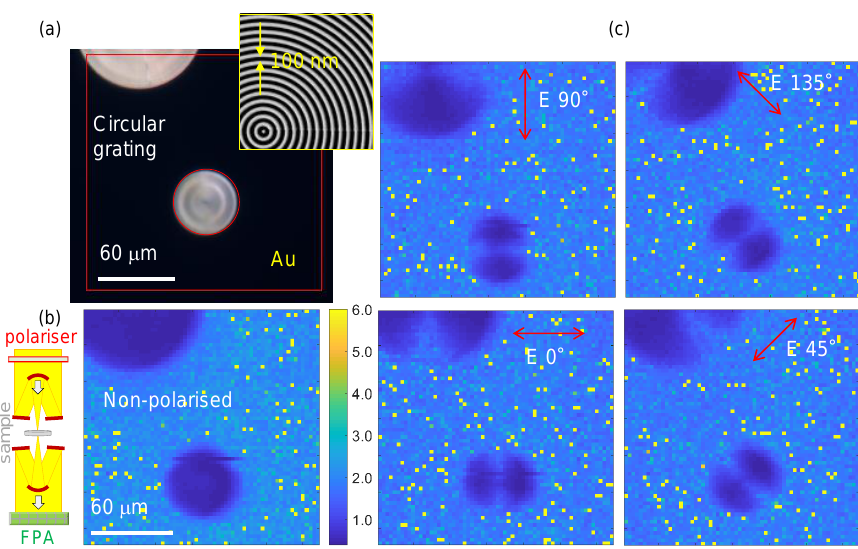
Figure 1. ( a ) Optical image of a circular grating milled through an Au-film on thin sapphire; inset shows SEM image. The grating was milled by Ga + -ions in a 100-nm-thick Au film sputtered on 30- µ m-thick sapphire; grating: 100-nm-half-pitch. ( b ) Wavenumber 3000 cm − 1 polarisation dependence of the absorbance A = − log ( T ) , where T is transmittance, measured through a circular grating. Inset on the left shows the principle of transmission measurements using a reflective Cassegrainian objective lens with a grid polariser and focal plane array (FPA) imaging. ( c ) Orientation dependence of the absorbance; E-field orientation is marked. The light source was thermal-IR. FPA-FTIR images were taken using 64 × 64 pixels of the FPA detector. The pixel size was 2.8 µ m, the Cassegrainian objective lens magnification was 15 × , and numerical aperture NA = 0.4 corresponding to the diffraction limit of 0.61 λ / NA = 5 µ m, a spectral resolution of 8 cm − 1 , and an accumulation of over 128 scans.